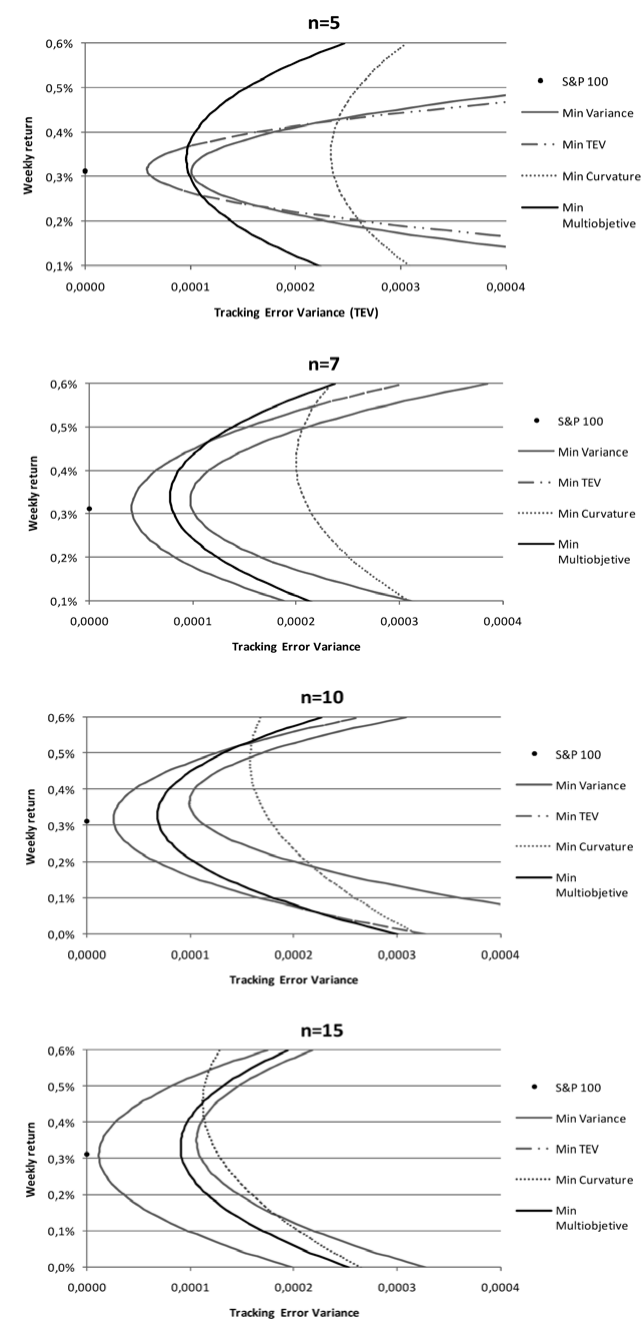
Fig. 3. Graphical representation of the TEV versus the weekly returns for the multiobjective model and the three monoobjective models. Cardinality: n = 5, 7, 10,